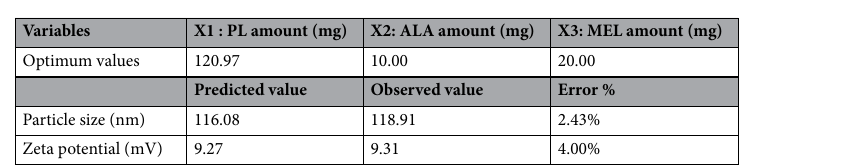
Table 4. Optimized independent variables’ levels and the predicted and observed responses of the optimized FLV-PL-ALA-MEL nanoformula.